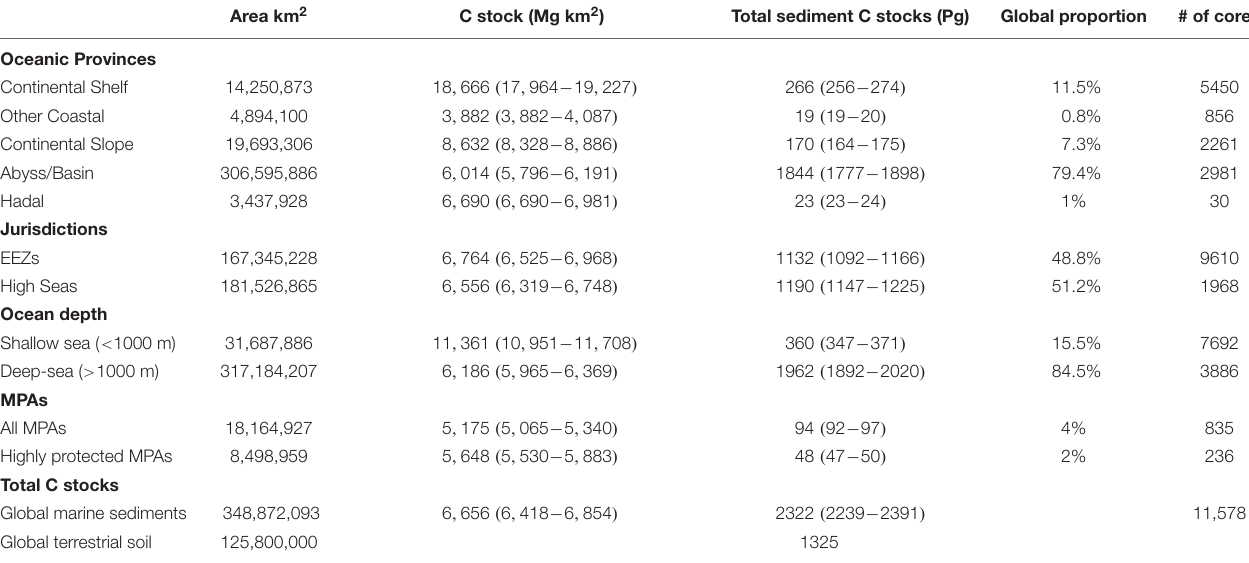
TABLE 2 | Global extent, average (95% confidence intervals) carbon (C) stocks in the top 1 m, and proportion of the global marine sediment C stock in the top 1 m for different oceanic provinces, marine jurisdictions [Exclusive Economic Zones (EEZ)], ocean depths, marine protected areas (MPAs), including implemented highly and fully protected areas, and total marine sedimentary C stock for the global